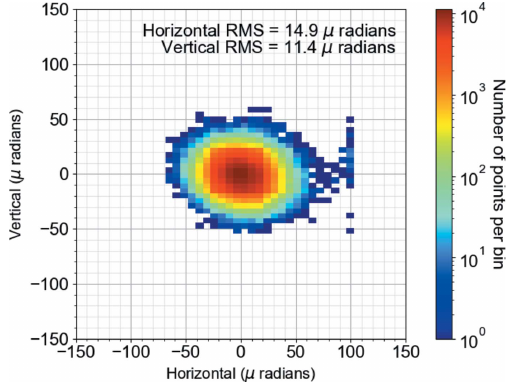
Figure 8 2D histogram of the pointing stability of the TOPAS output beam in the horizontal and vertical directions.